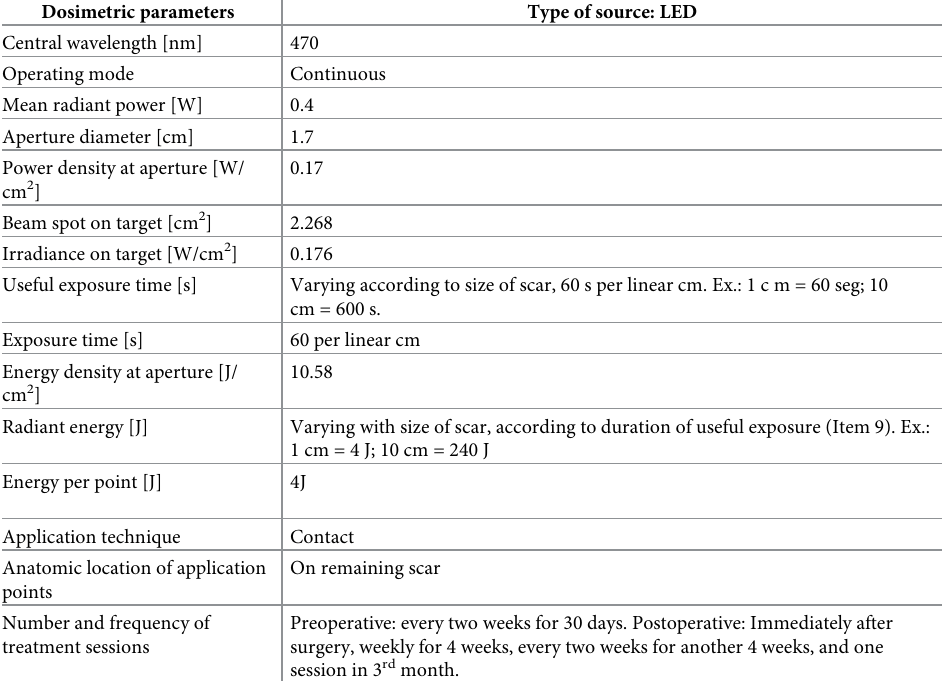
Table 1. Dosimetric parameters of photobiomodulation